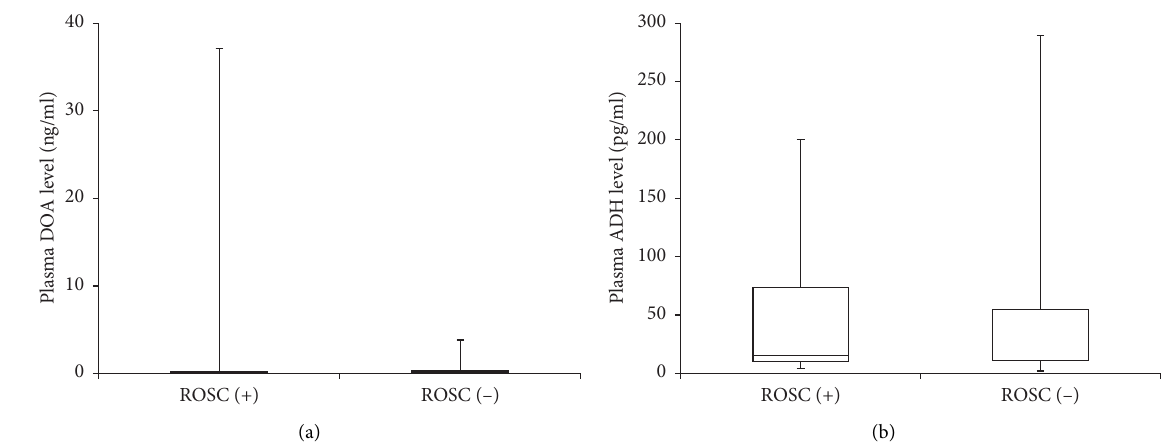
Figure 3: Comparisons of DOA and ADH levels in the plasma. (a) Comparison of DOA levels in the plasma. The normal level of DOA in the plasma is ≤ 0.03ng/ml. (b) Comparison of ADH levels in the plasma. The normal level of ADH in the plasma is ≤ 4.2pg/ml. DOA: dopamine and ADH: antidiuretic hormone